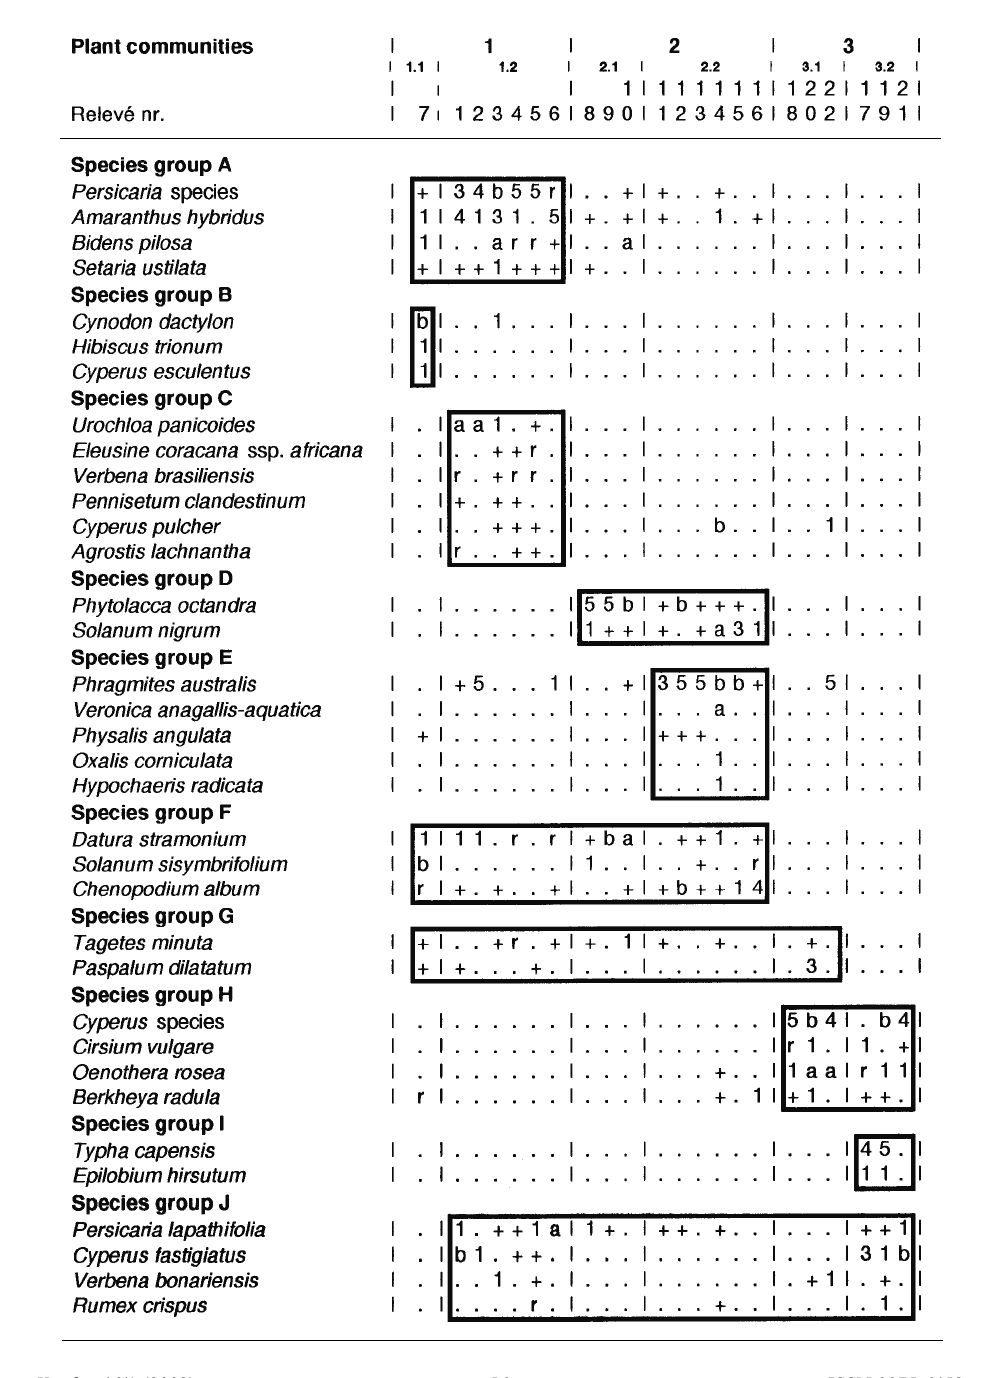
Phytosociological table of pioneer vegetation on the rehabilitated peatland at Rietvlei Nature